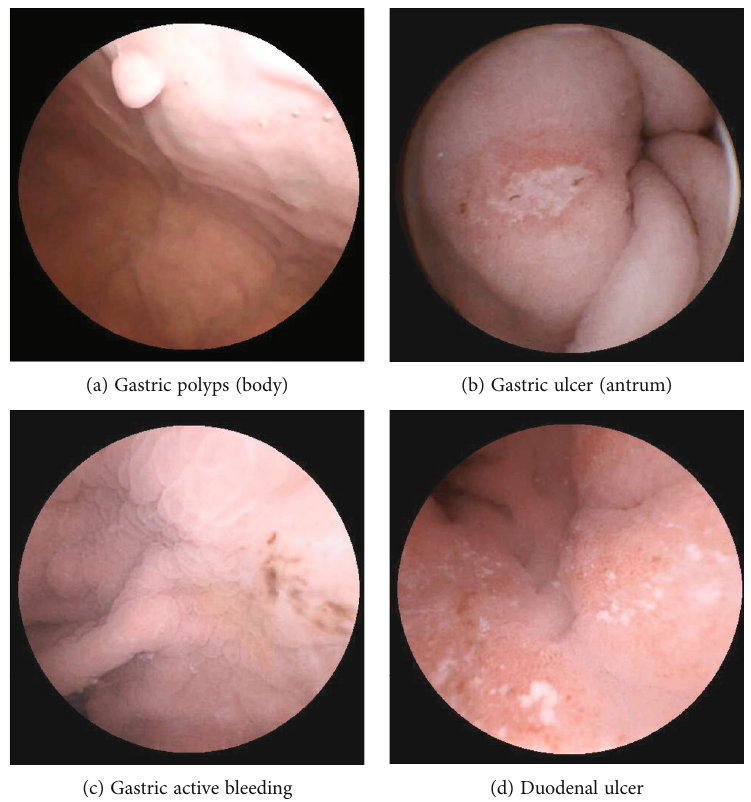
Figure 2: Representative focal (a – d) lesions detected by